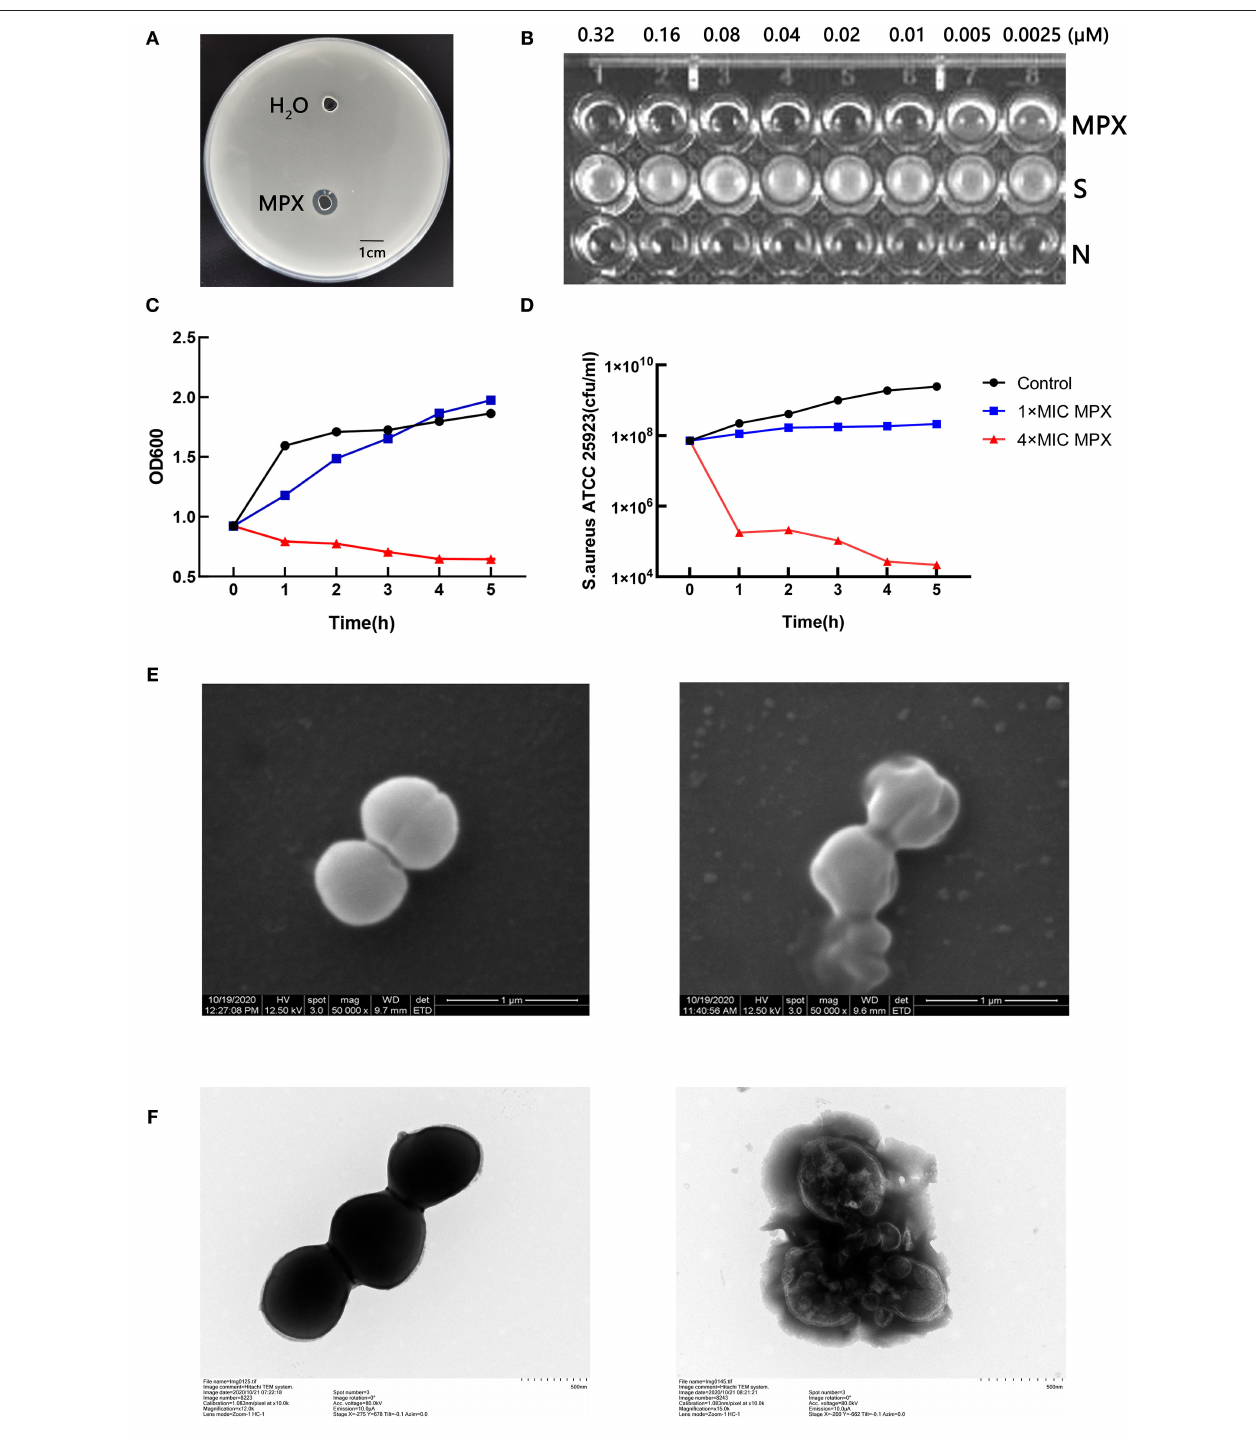
FIGURE 1 | Detection of the bactericidal activity of the antimicrobial peptide MPX. (A) The agar diffusion test of the antimicrobial activity of MPX against S. aureus ATCC 25923. (B) MIC results. S: S. aureus ATCC 25923; N: blank LB medium. (C) OD 600 measurement of bacterial culture after the action of MPX for different times. (D) The determination of the number of viable bacteria after the action of MPX for different times. (E) Scanning electron microscopy observation of the effect of MPX on S. aureus ATCC 25923. The left picture shows the normal morphology of S. aureus , and the right picture shows the bacterial morphology of S. aureus after MPX (1 × MIC) exposure. (F) Transmission electron microscopy observation of the effect of MPX on S. aureus ATCC 25923. The left picture shows the normal morphology of S. aureus , and the right picture shows the bacterial morphology of S. aureus after MPX (1 × MIC) exposure. Error bars indicate the mean ± SEM, n = 3. Statistical significance was defined as ** p < 0.01 and *** p <